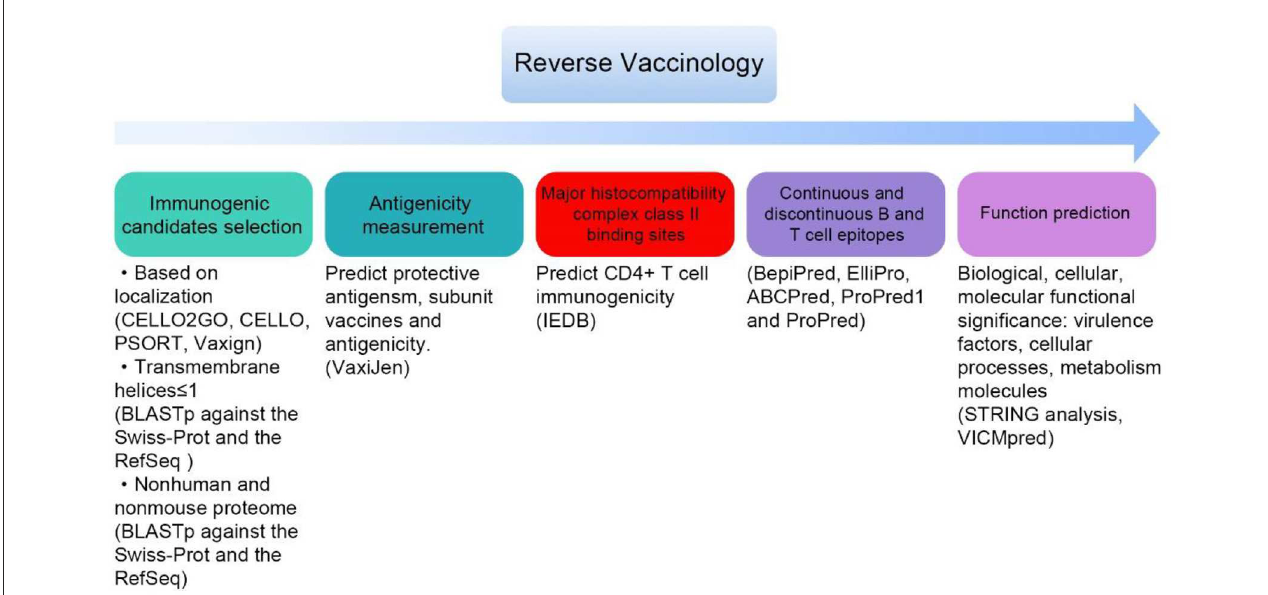
FIGURE2 General steps for screening candidate vaccines by reverse vaccinology (some databases and tools in bracket).